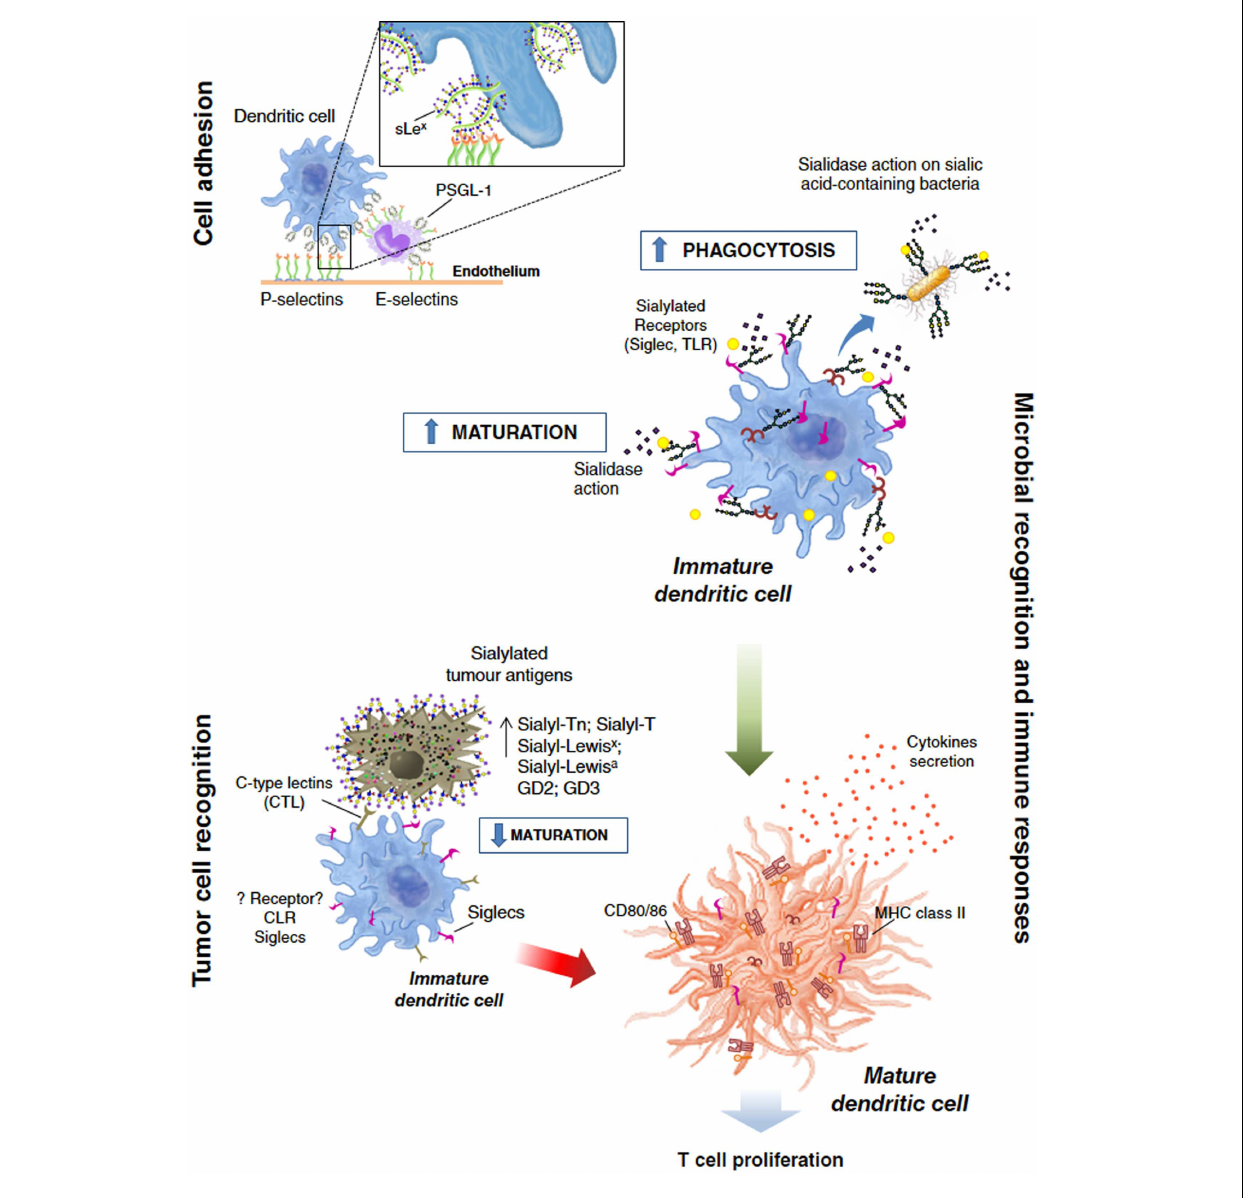
and homing; or in “de facto” immune processes such as tumor cell recognition and microbial recognition , overall modulating the immune response/tolerance